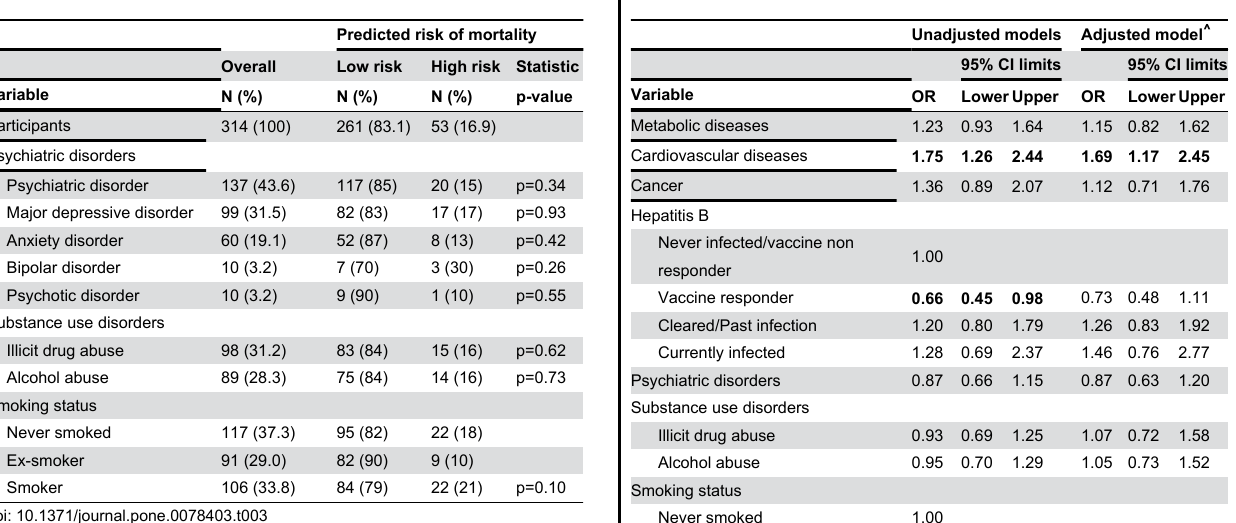
Table 3. Prevalence of psychiatric disorder as per total cohort and listed as per predicted high or low risk mortality as estimated by VACS index.